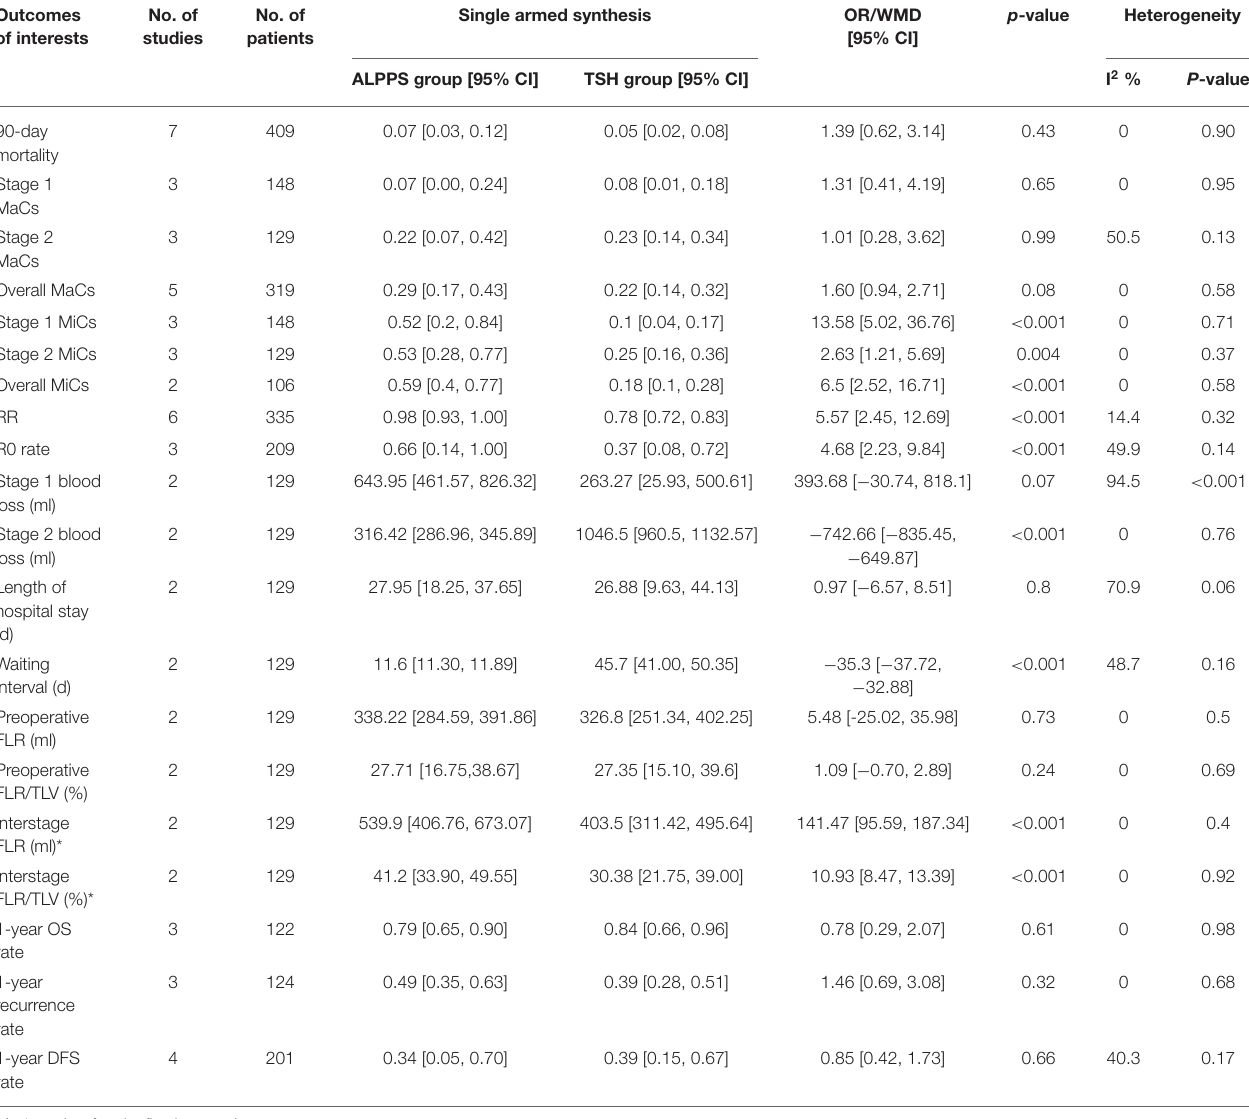
TABLE 2 | Meta-analysis of ALPPS vs. TSH